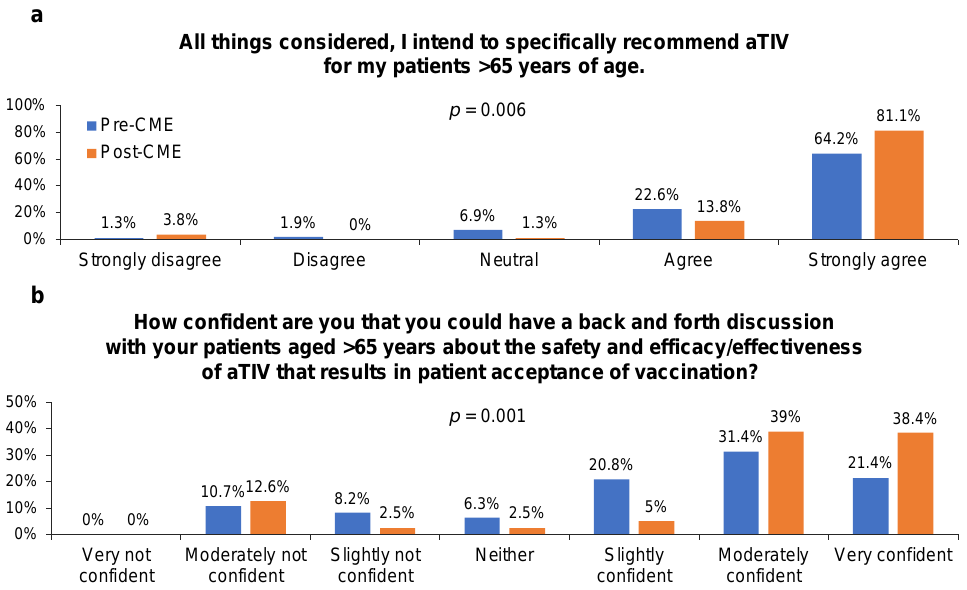
Figure 2. Self-reported rating on a scale of 1 – 10 of general practitioners’ (n = 159) confidence in their ability to address potential reasons for influenza vaccine hesitancy by patients before and after participating in an accredited continuing medical education (CME) program.